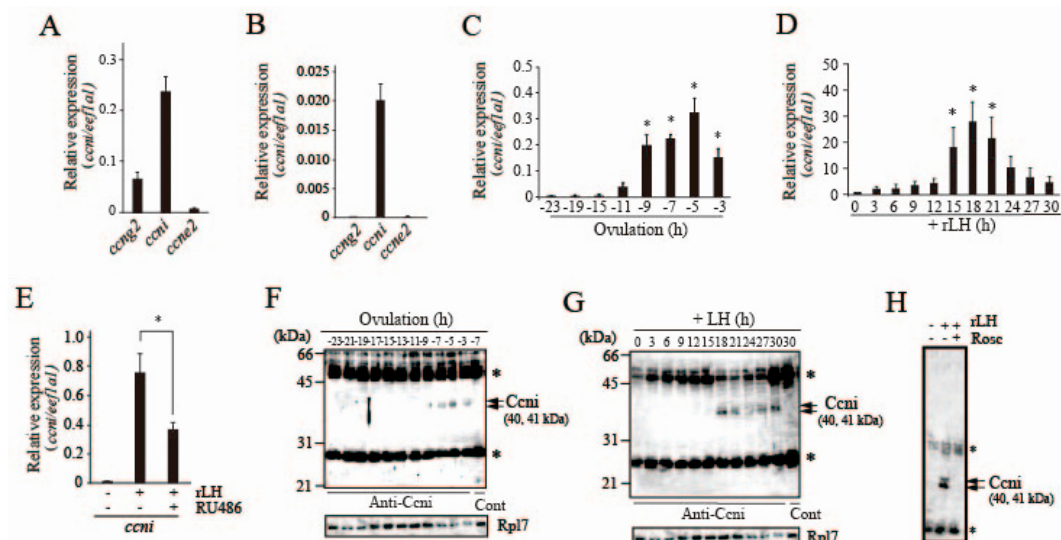
Figure 6. Expression of cyclins in the medaka ovary. ( A ) Relative expression levels of ccn transcripts were determined by real-time RT-PCR using total RNAs derived from follicle layers of preovulatory follicles isolated 6 h before ovulation. ( B ) Relative expression levels of ccng2 , ccni , and ccne2 transcripts were determined by real-time RT-PCR using total RNAs of granulosa cells isolated from the − 6 h-follicles. ( C ) Total RNAs were prepared from the follicles at various time points in the 24 h spawning cycle and were used for real-time RT-PCR of ccni mRNA. The expression levels were normalized to those of eef1a1. Asterisks indicate a significant difference at p < 0.05 (*) (Kruskal–Wallis test, N = 5–7). ( D ) The − 22 h-follicles were incubated in vitro with or without recombinant medaka LH (100 µ g/mL). At various time points of incubation, total RNAs were prepared from follicles and used for real-time RT-PCR of ccni mRNA. The expression levels wre normalized to those of eef1a1 and expressed as the fold change compared to levels of 0 h follicles. Asterisks indicate a significant difference at p < 0.05 (*) (Kruskal–Wallis test, N = 4–5). ( E ) The − 22 h-follicles were incubated with recombinant medaka LH (100 µ g/mL) with or without RU-486 (100 µ M). After 18 h of incubation, total RNA was extracted from the follicles and used for real-time RT-PCR analysis of ccni mRNA. The expression levels were normalized to those of eef1a1 . An asterisk indicates a significant difference at p < 0.05 (*) ( t -test, N = 4). ( F ) Expression of Ccni protein in the preovulatory follicles was analyzed. Extracts of the follicles were prepared at various time points in the 24 h spawning cycle and immunoprecipitated using the specific Ccni antibody. The immunoprecipitated materials were then analyzed by western blotting using the same antibody. Asterisks indicate the band corresponding to the antibody used for immunoprecipitation. As a control, the − 7 h-follicle extracts were immunoprecipitated with normal IgG. ( G ) The − 22 h-follicles were incubated with medaka rLH (100 µ g/mL). At various time points of incubation, follicle extracts were prepared and immunoprecipitated with the Ccni antibody. The immunoprecipitated materials were then analyzed by western blotting using the same antibody. Asterisks indicate the band corresponding to the antibody used for immunoprecipitation. As a control, the follicles that had been incubated with medaka rLH for 30 h were immunoprecipitated with normal IgG. ( H ) The − 22 h-follicles were incubated with medaka rLH (100 µ g/mL) with or without roscovitine (Rosc; 50 µ M). After 18 h of incubation, the follicular extracts were immunoprecipitated using the Ccni antibody, and the resultant materials were analyzed by western blotting using the same antibody. An asterisk indicates the bands corresponding to the antibody used for immunoprecipitation.